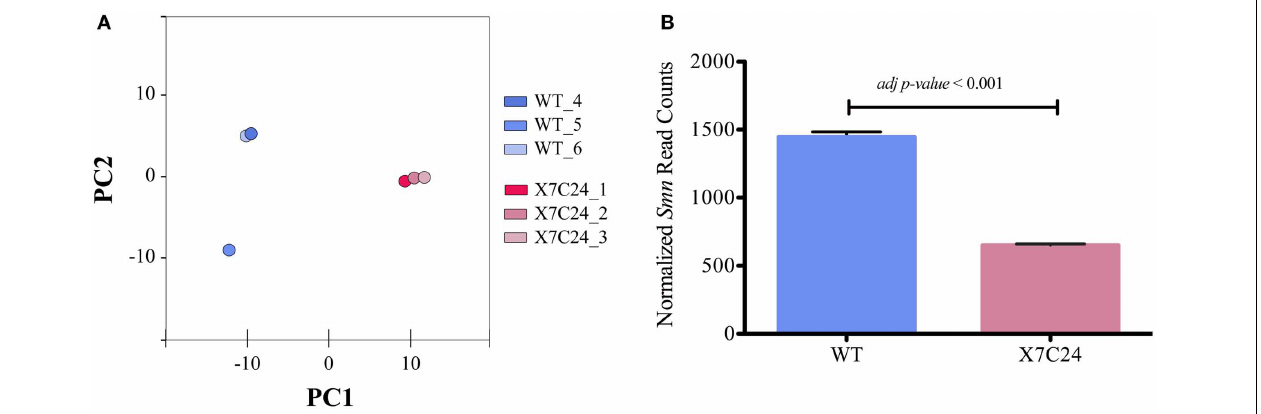
∼ 12,000 genes expressed in WT and X7/C24 samples. (B) Normalized reads counts of Smn gene in WT and X7/C24 phenotypes. The transgenic X7/C24 presents a transcriptome profile that clearly distinguishes it from the WT and displays a significant down-regulation of the siRNA target gene Smn .